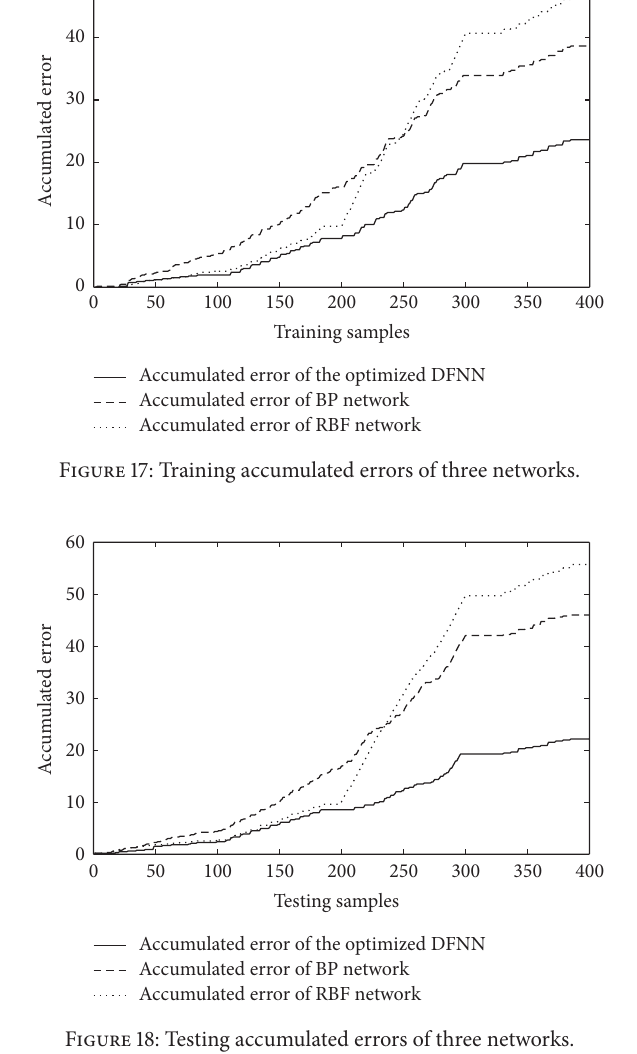
method has the best performance compared to other three